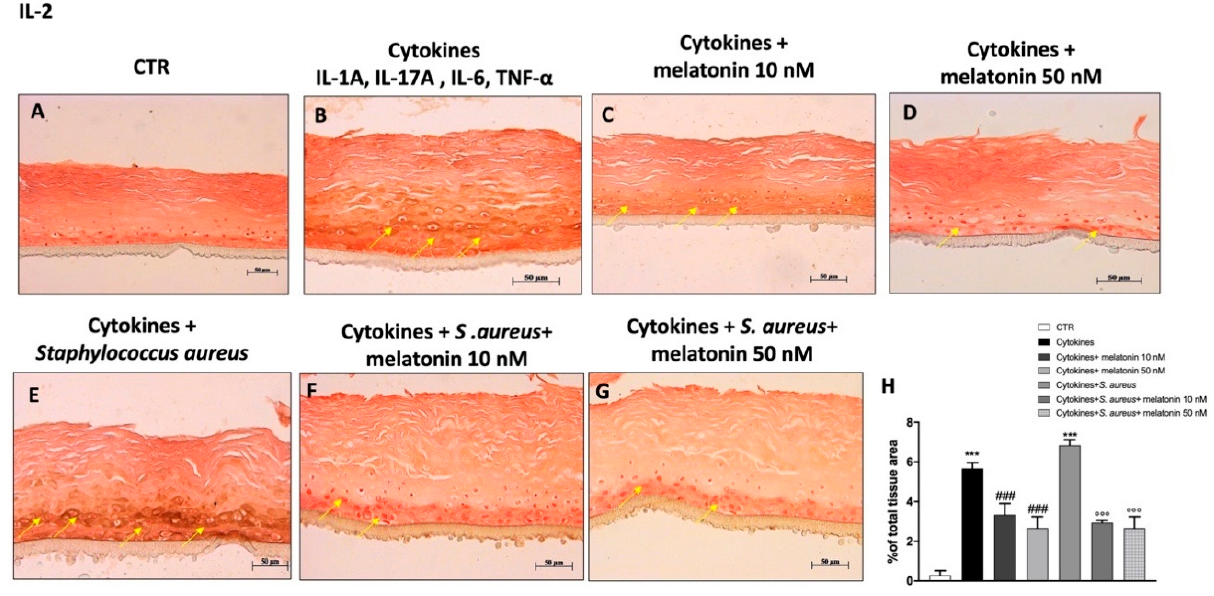
Figure 8. Effect of melatonin on IL-2 expression. Immunohistochemical staining revealed that the cytokines and S. aureus group were characterized by an increase of IL-2 expression compared to the control ( A , B , E ); whereas, melatonin treatment at 10 nM and 50 nM significantly reduced its expression ( C , D , F , G ). The yellow arrows indicate the positive staining. Data are representative of at least three independent experiments. ( H ) *** p < 0.001 vs. CTR; ### p < 0.001 vs. cytokines group. °°° p < 0.001 vs. cytokines + S. aureus group.